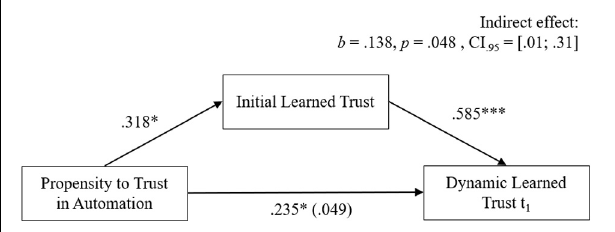
FIGURE 4 | Mediation model for the three investigated trust